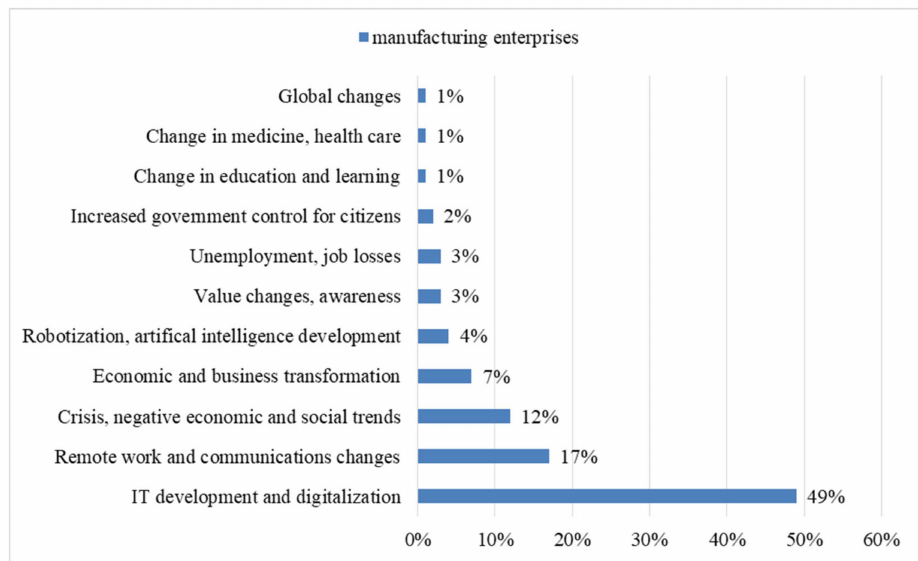
Figure 5. Opinion of respondents of manufacturing enterprises of the Republic of Mordovia about changes in the situation in the world.